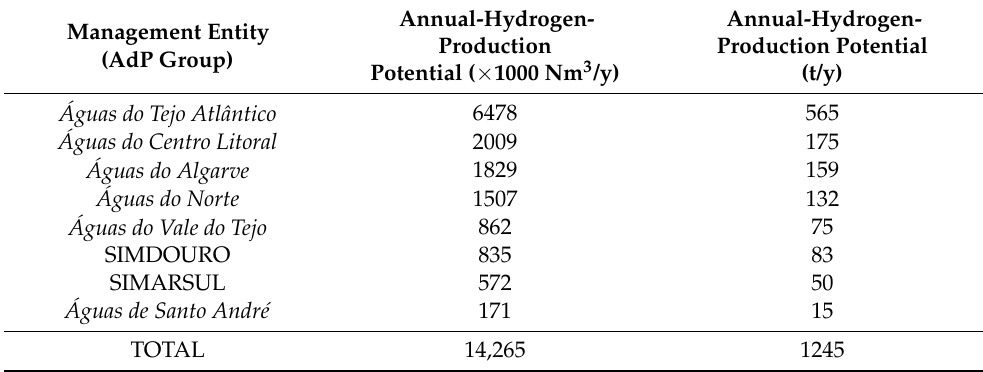
Table 5. Potential-hydrogen-production values from dewatered-sludge gasification provided by management entities from AdP